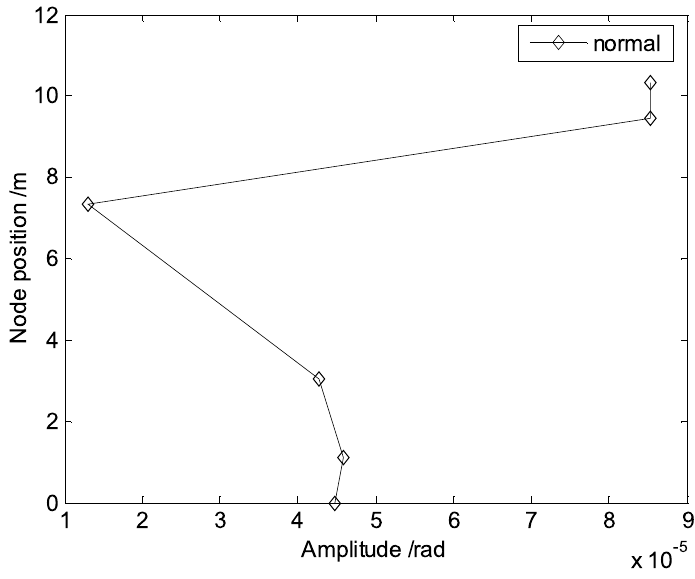
Fig. 9. Deflection angles of shaft when elastic oil tanks work